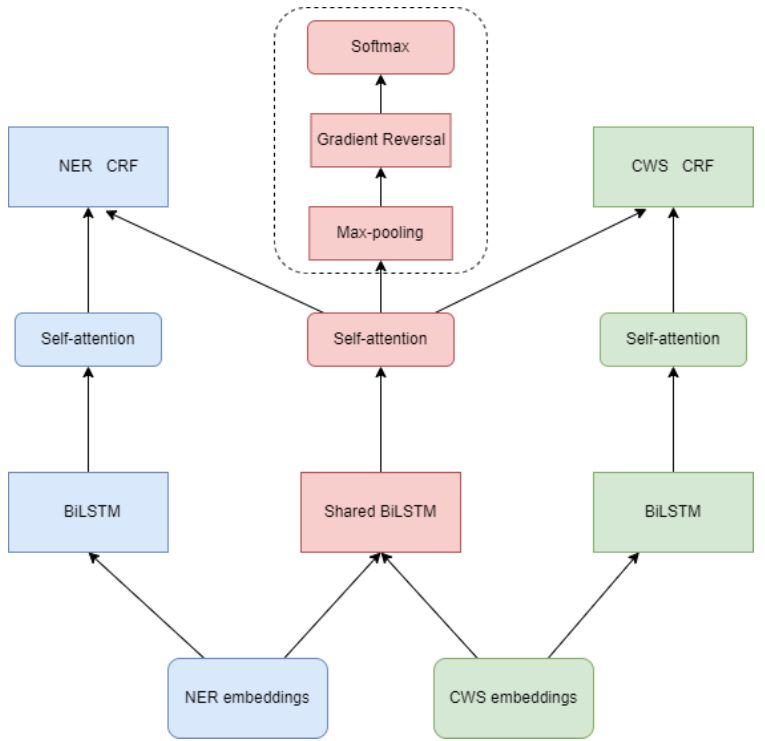
Figure 7. Named Entity Recognition model. (Consists of BiLSTM, Self-attention, CRF, feature